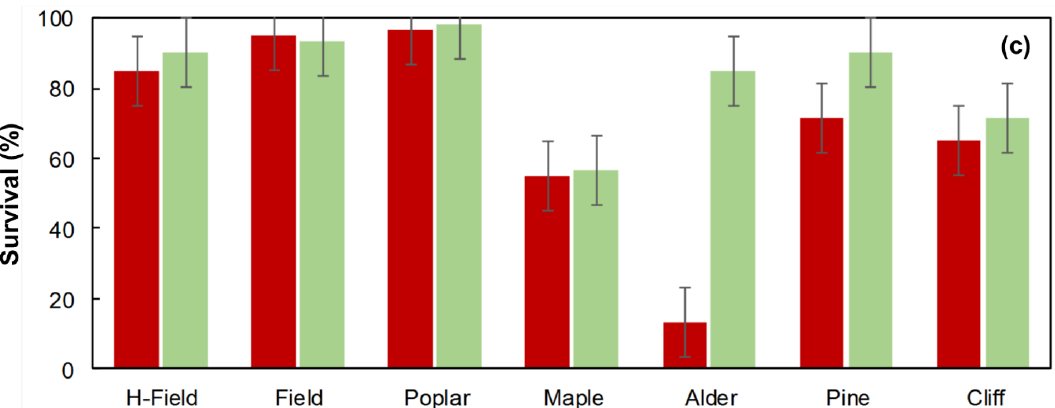
Figure S2. Plantation environment × Species interaction for ( a ) total stem volume ( p < 0.001); ( b ) total stem biomass ( p < 0.001); and ( c ) survival ( p < 0.05) after 18 years in bur oak ( Q . macrocarpa ) and red oak ( Q . rubra ) restoration plantations. H-field